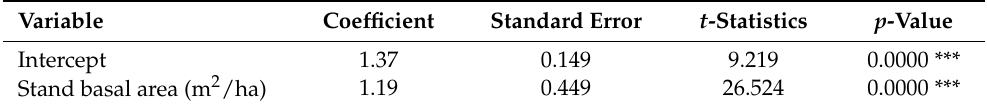
Table 4. Regression analysis result of stand basal area and aboveground biomass (AGB).